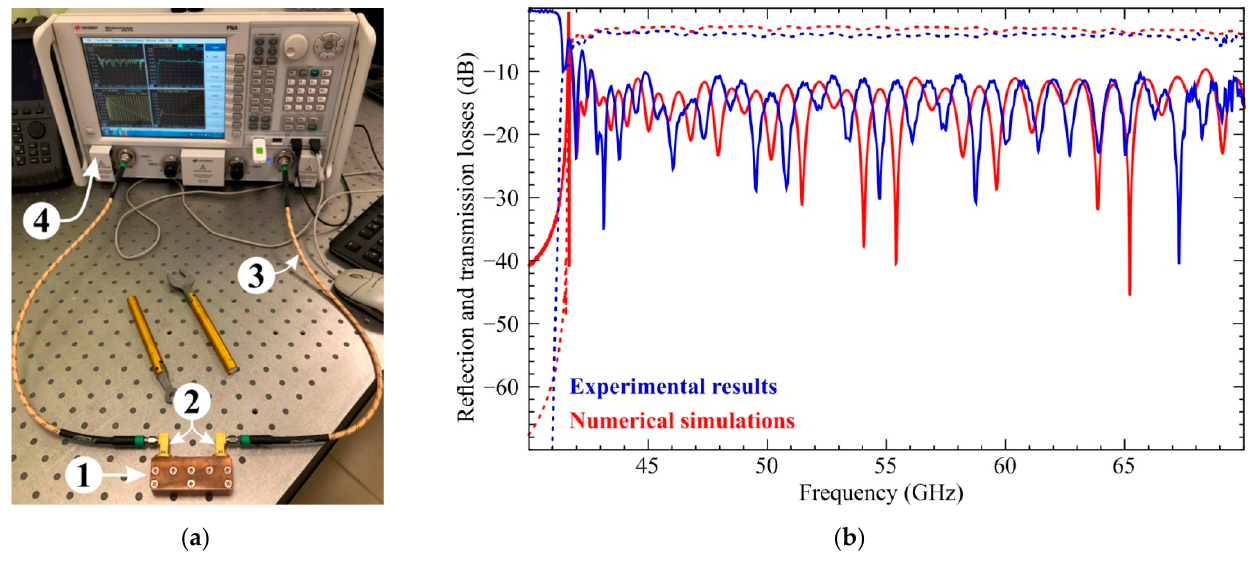
Figure 7. ( a ) A photo of the experimental equipment used for cold ‐ test measurements. The numbers denote: 1—Copper ‐ made full ‐ length interaction structure, 2—Coax ‐ to ‐ waveguide adapters, 3—Co ‐ axial cables, 4—vector network analyzer; ( b ) a comparison of the experimental data (blue) and nu ‐ merical simulation (red): the solid lines represent the reflection losses, while the dashed lines denote the transmission losses.